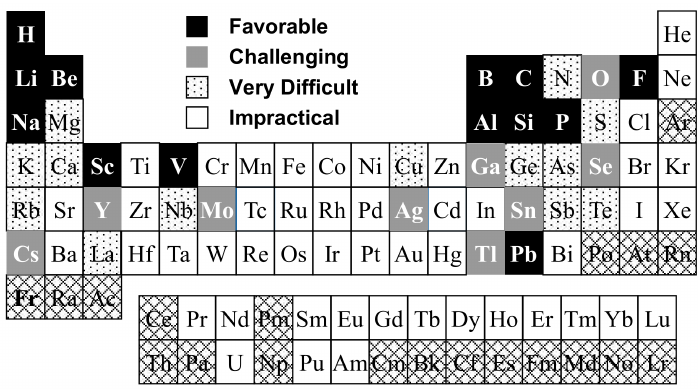
Figure 1. A practical categorization of elements in the NMR study of inorganic glasses. In addition to those identified in the legend, the cross-hatched boxes denote elements that are widely considered impossible for solid-state